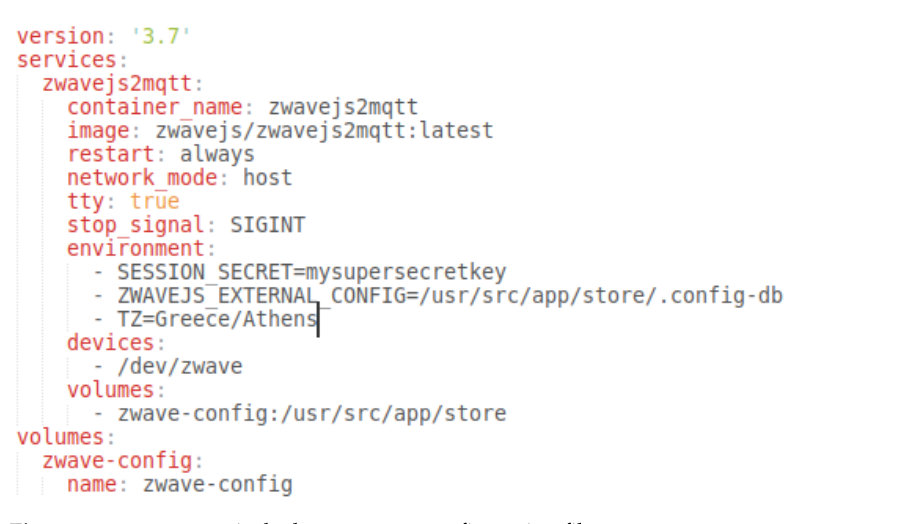
Figure 3. zwavetomqttjs docker compose configuration file.